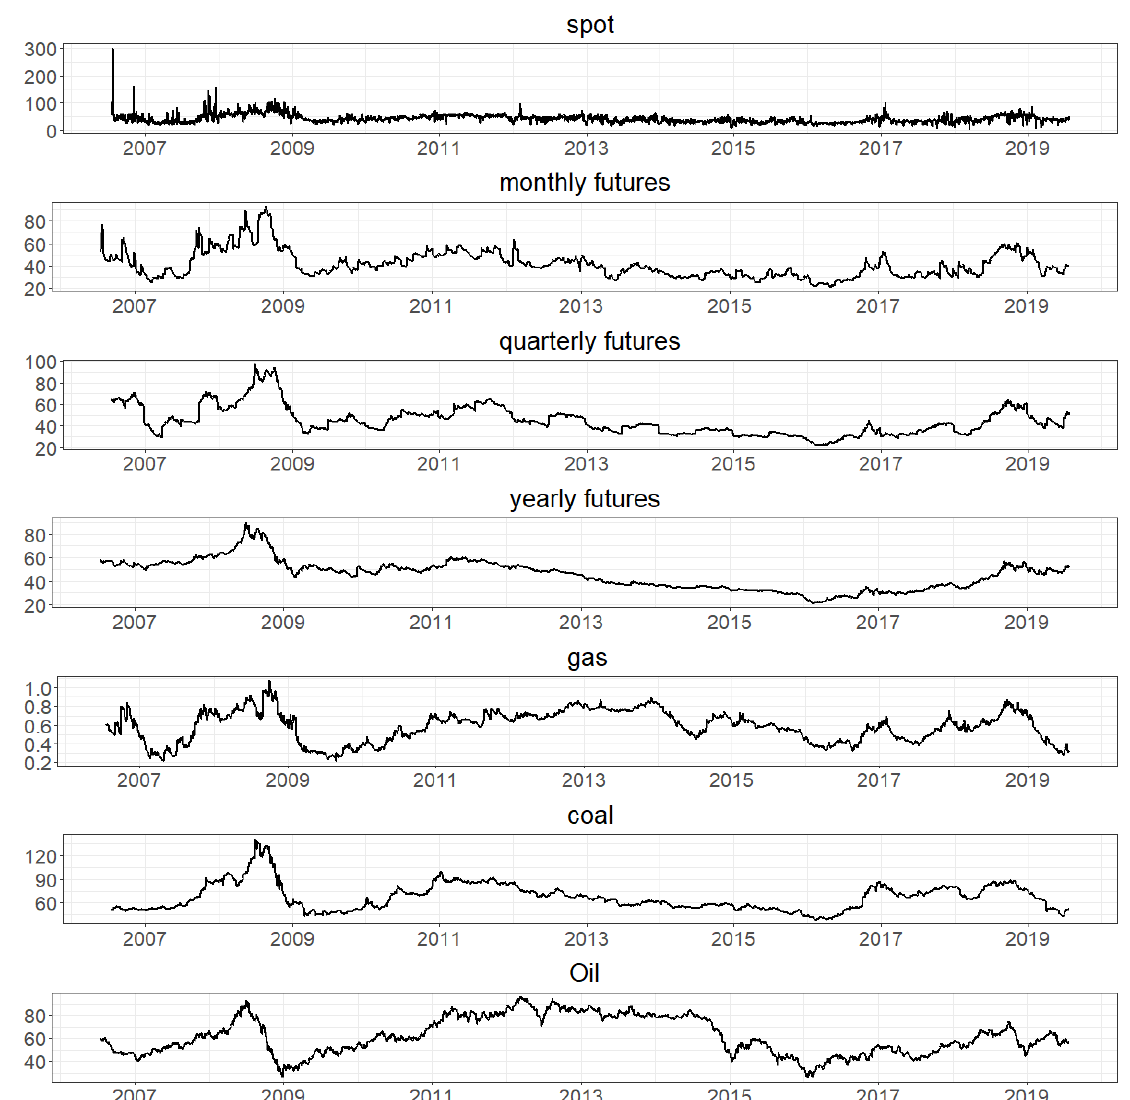
Figure 1. Time-variations of the price series. Note: spot: EPEX Germany Baseload Spot; monthly futures: EEX Germany Baseload Monthly Futures; quarterly futures: EEX Germany Baseload Quarterly Futures; yearly futures: EEX Germany Baseload Yearly Futures; gas: ICE UK Natural Gas Monthly Futures; coal: ICE Rotterdam Coal Monthly Futures; oil: ICE Brent Crude Oil Monthly Futures; the units of electricity spot, monthly futures, quarterly futures, and yearly futures are EUR/Mwh; the units of gas, coal, oil are EUR/therm, EUR/metric ton, and EUR/barrel, respectively.